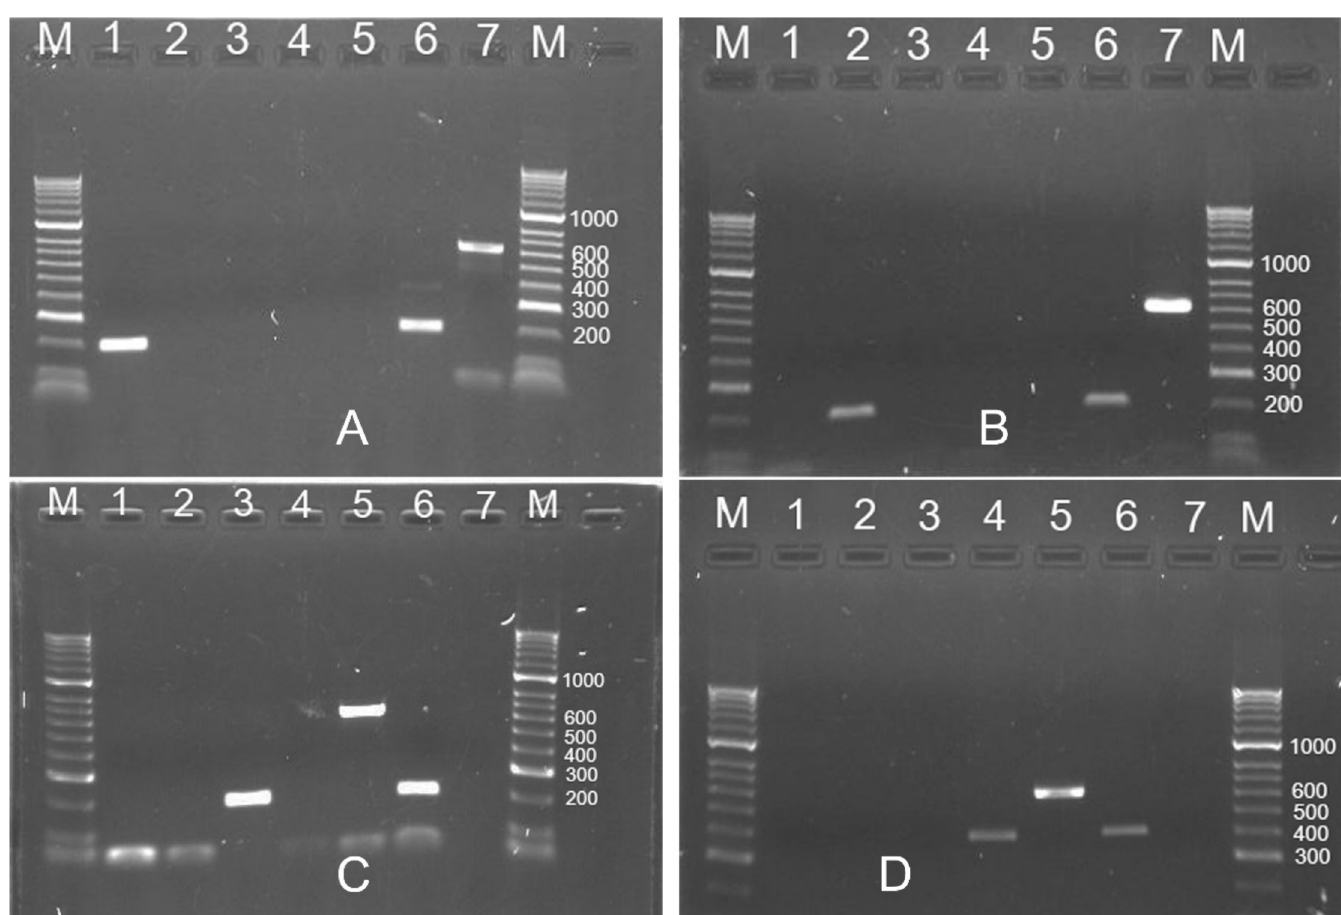
Fig 4. Simplex PCR results for four common Meloidogyne species from turfgrass using species-specific primers. A. Simplex PCR results using M . graminis -specific primers (Mg28SFs/RK28SUR). M: HyperLadder II DNA Marker; 1: M . graminis (DNA ID: 48); 2: M . marylandi (2); 3: M . naasi (22); 4: M . incognita (19); 5: Water; 6: Mixed DNA of four species (2, 19, 22 and 48); 7: M . graminis (48) (Universal primers, RK28SF/MR). B. Simplex PCR results using M . marylandi -specific primers (Mm28SFs/RK28SUR). 1: M . graminis (48); 2: M . marylandi (2); 3: M . naasi (22); 4: M . incognita (19); 5: Water; 6: Mixed DNA of four species (2, 19, 22 and 48); 7: M . marylandi (2) (Universal primers, RK28SF/MR). C. Simplex PCR results using M . naasi -specific primers (Mn28SFs/ RK28SUR). 1: M . graminis (48); 2: M . marylandi (2); 3: M . naasi (22); 4: M . incognita (19); 5: M . naasi (22) (Universal primers, RK28SF/MR); 6: MixDNA of four species (2, 19, 22 and 48); 7: Water. D. Simplex PCR results using M . incognita -specific primers (Inc-K14-F/Inc-K14-R). 1: M . graminis (48); 2: M . marylandi (2); 3: M . naasi (22); 4: M . incognita (19); 5: M . incognita (19) (Universal primers, RK28SF/MR); 6: MixDNA of four species (2, 19, 22 and 48); 7: